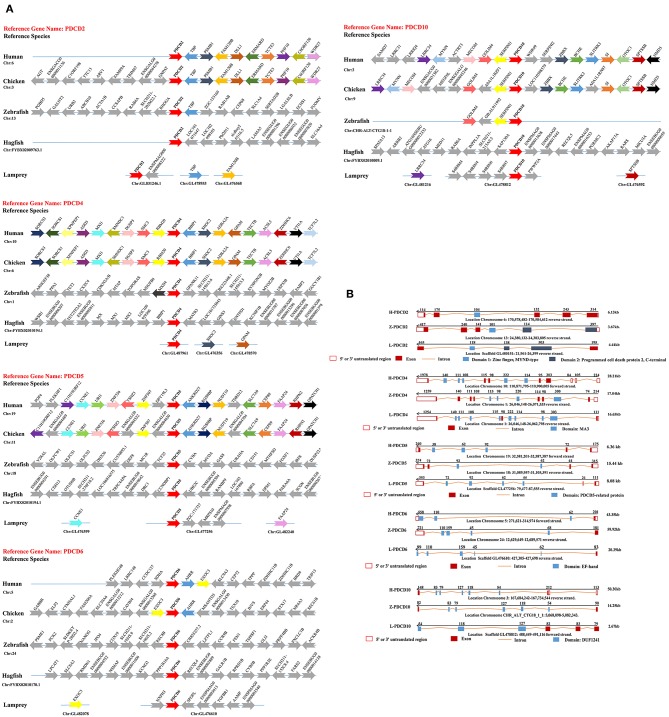
Syntenic relationships and gene structure in the PDCD family. (A) The conservation of genes neighboring PDCD family genes. The genes (10 kb) are indicated by arrowheads. The arrows and arrowheads pointing in opposite directions indicate genes located on opposite strands. Chr denotes the chromosome. (B) A representation of the available sequence data for the PDCD family genes. Noncoding exons are designated with open boxes, and coding exons are indicated by colored boxes. The transcription start site is indicated by an arrow, and the sizes of the 5' introns are labeled. PDCD exons that encode the domain are labeled.